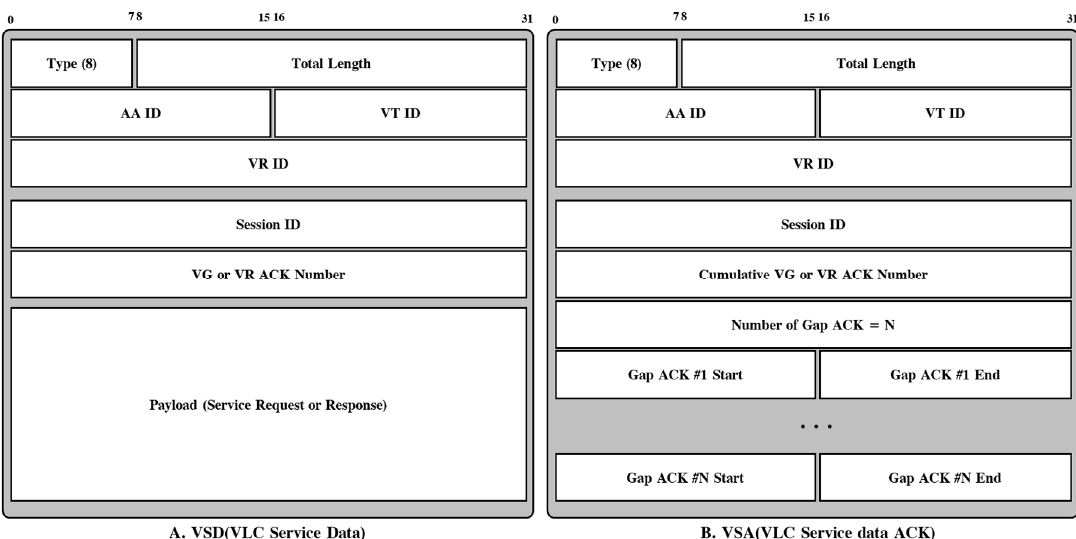
Figure 13. Data retransmission operations by loss detection with Gap ACK.